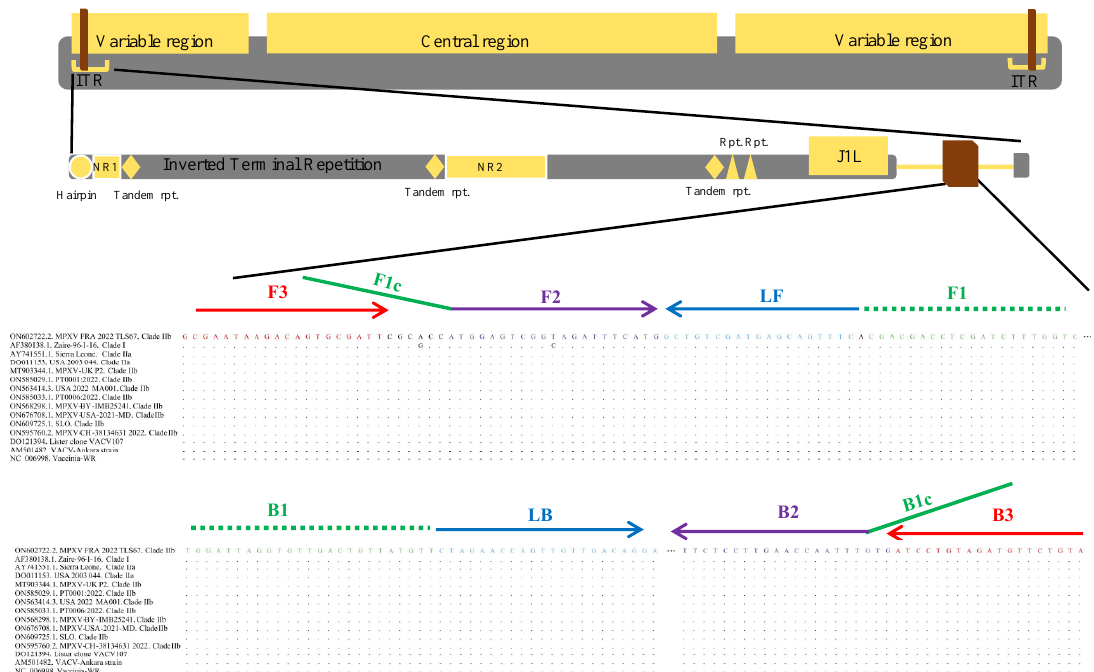
Figure 1. LAMP primer design. Schematic showing location of primer recognition sites around the N4R gene, which is duplicated in left and right inverted terminal repetitions (ITR) of the mpox genome. The positions from 5840nt/190765nt to 6339nt/191264nt are based on the complete genome of MPVX-FRA-2022-TLS67 (GenBank accession: ON602722.2). Outer primers (F3, B3) are indicated by red line arrows, internal primers (BIP and FIP) are indicated by green and purple line arrows, loop primers (LB, FB) are indicated by blue line arrows.